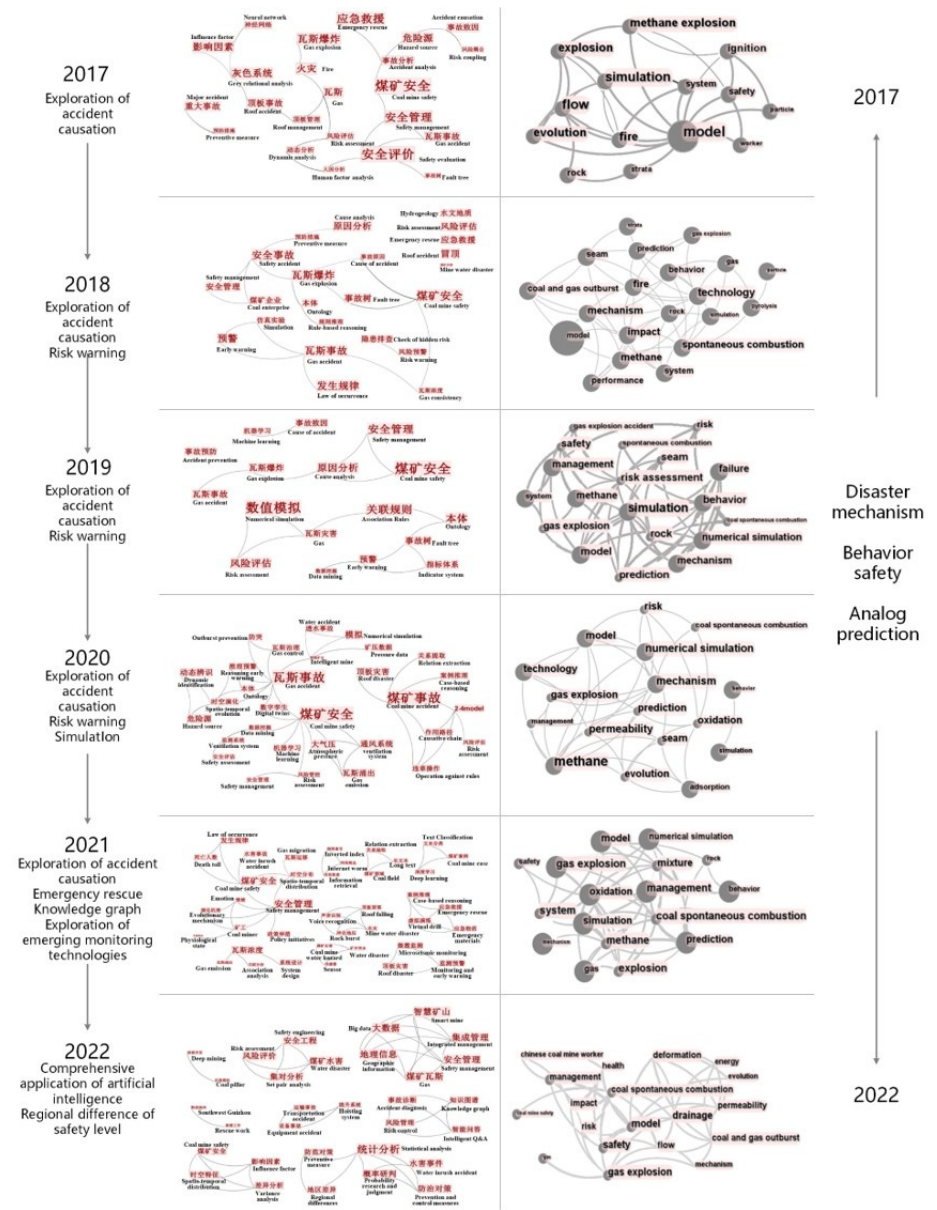
Figure 12. Comparison of Chinese and English research hotspots during 2017–2022.